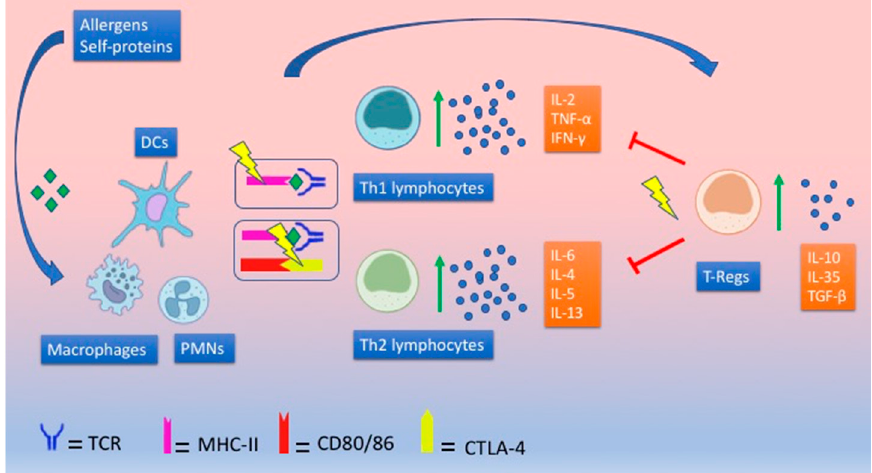
Figure 2. Immunological response in children with autoimmune/atopic diseases. Children devel- oping both asthma and T1DM show high levels of both Th1 and Th2 cytokines. Anti-inflammatory cytokines, such as IL-10, are also highly expressed, even if they do not further increase after stimu- lation in vitro. This pattern characterized by “exhausted” Tregs might be caused by a defect in T CD4+ inhibition by IL-10, polymorphisms in HLA genes, and defects of CTLA-4 in association with environmental triggers. Yellow lightening symbols in the picture mark the possible defective sites of immunoregulation.